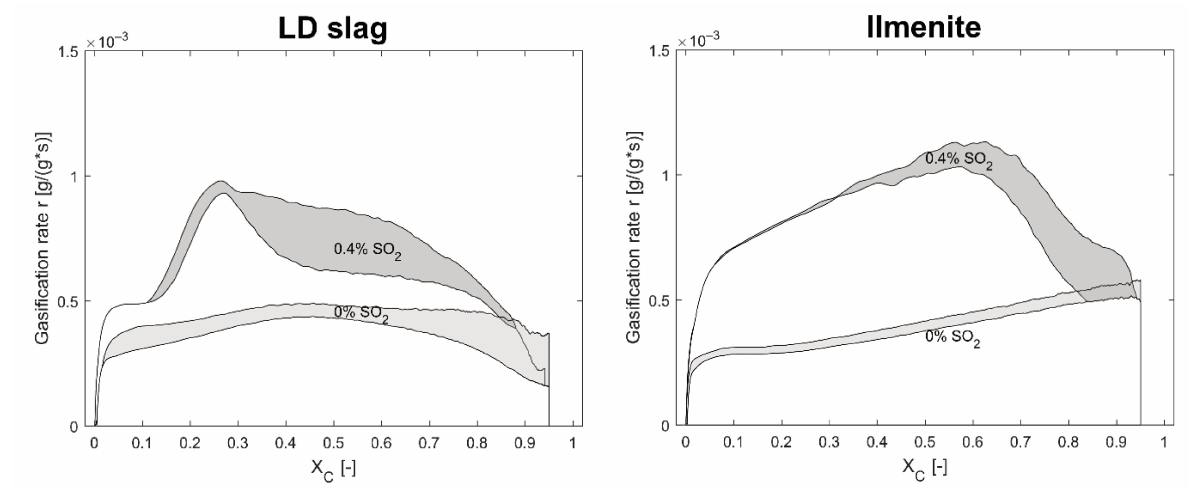
Figure 6. Gasification rate “r” as a function of the char conversion X c for LD slag and ilmenite with SO 2 and without SO 2 in the ingoing gas at 870 ◦ C using devolatilized wood pellets. The gray area indicates the reproducibility and is bordered by the highest and lowest gasification rate for the repeated experiments.